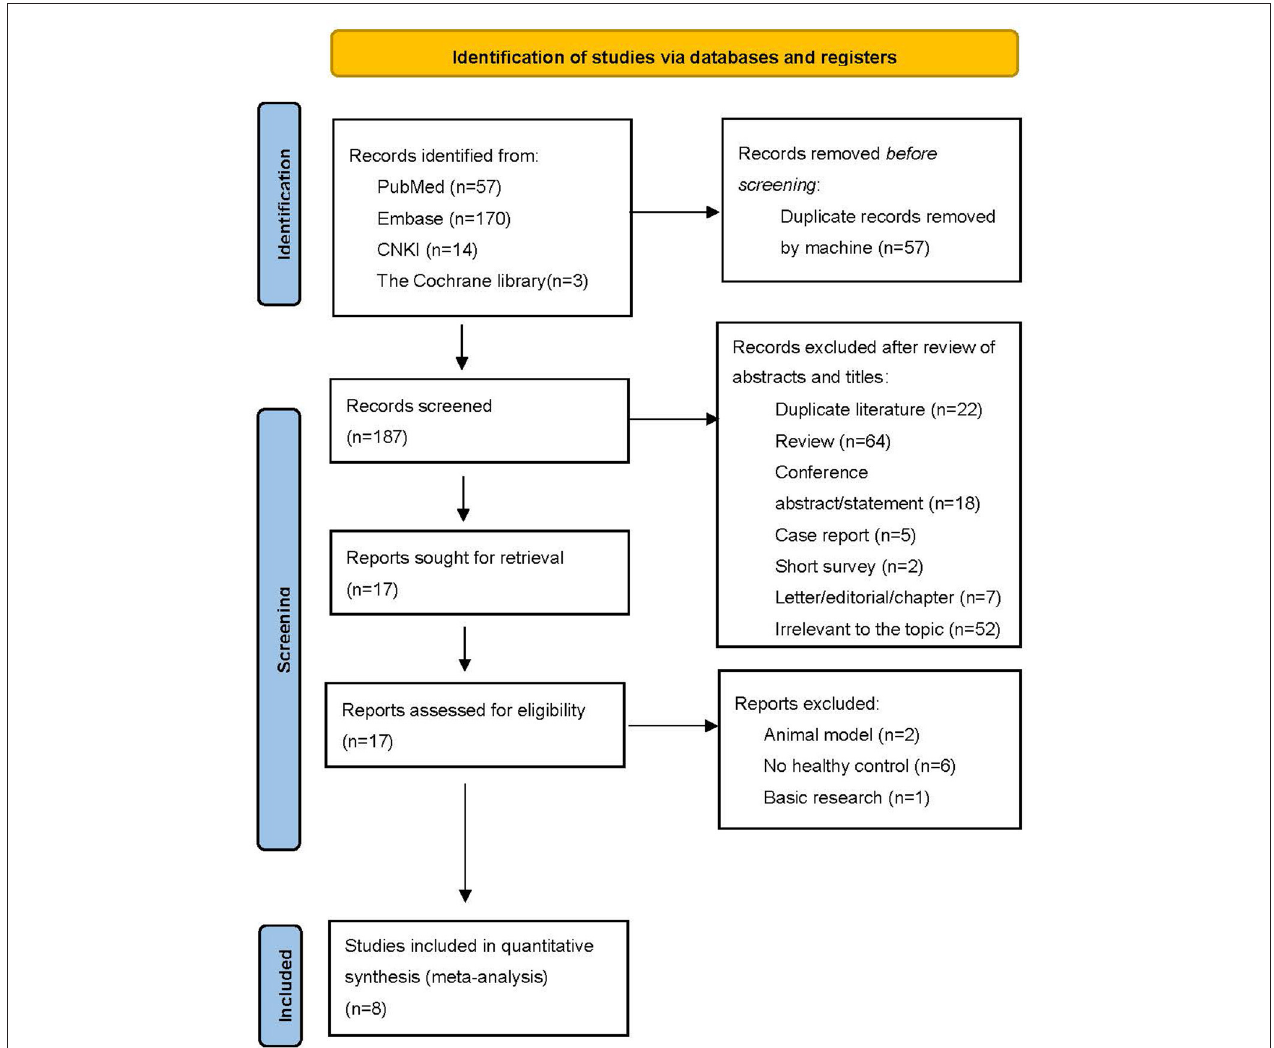
FIGURE 1 | Flow diagram of literature